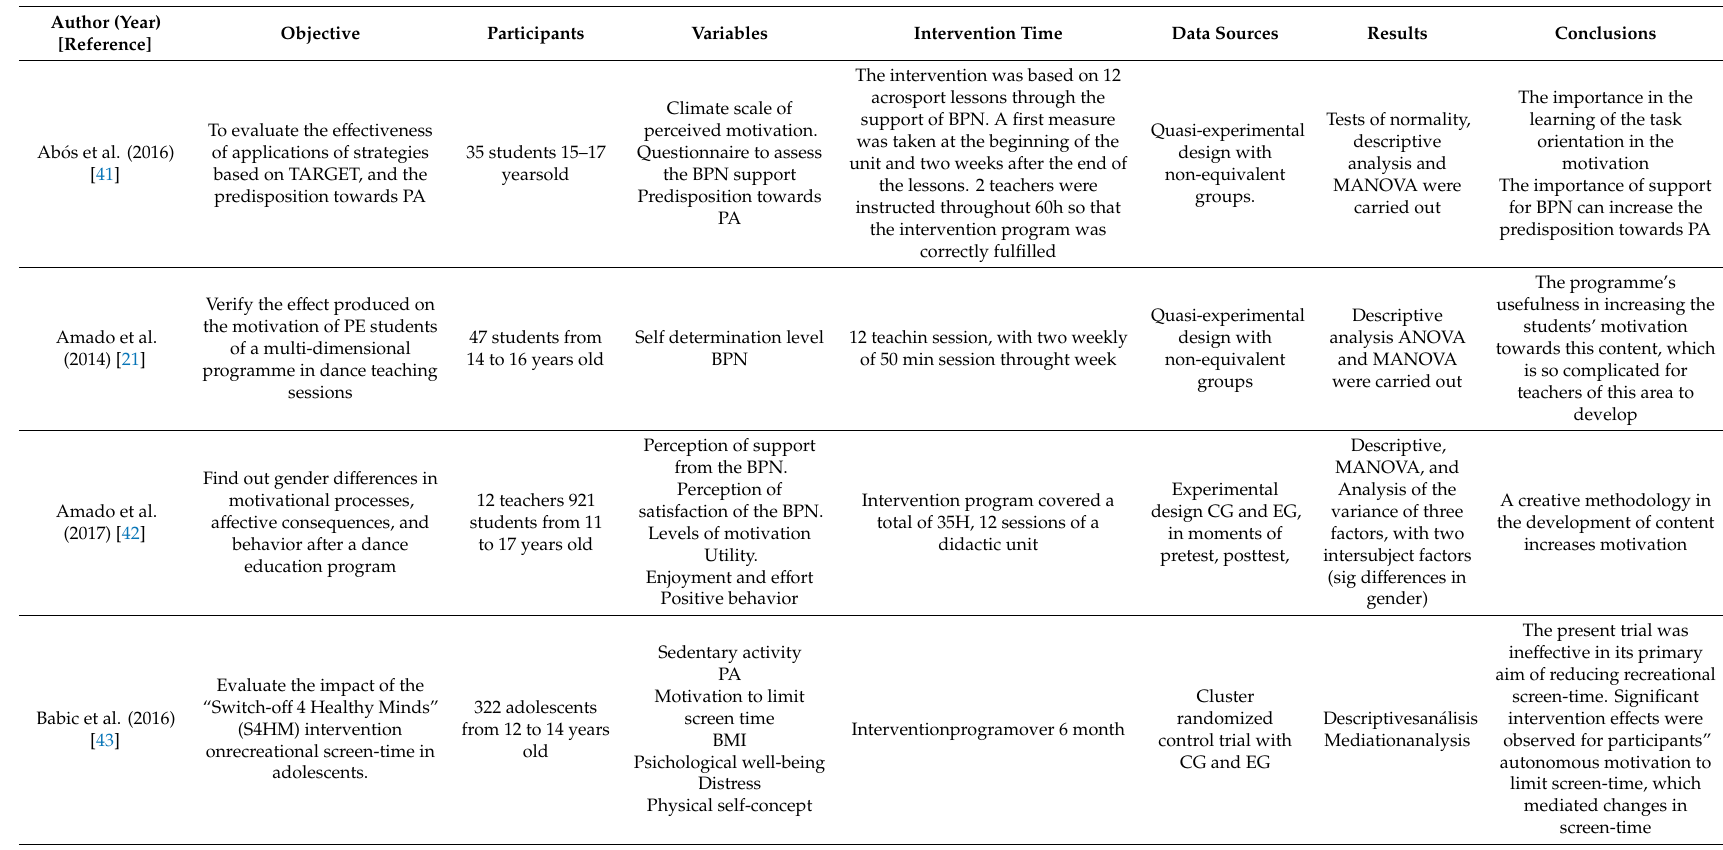
Table 3. Characteristics of study design and